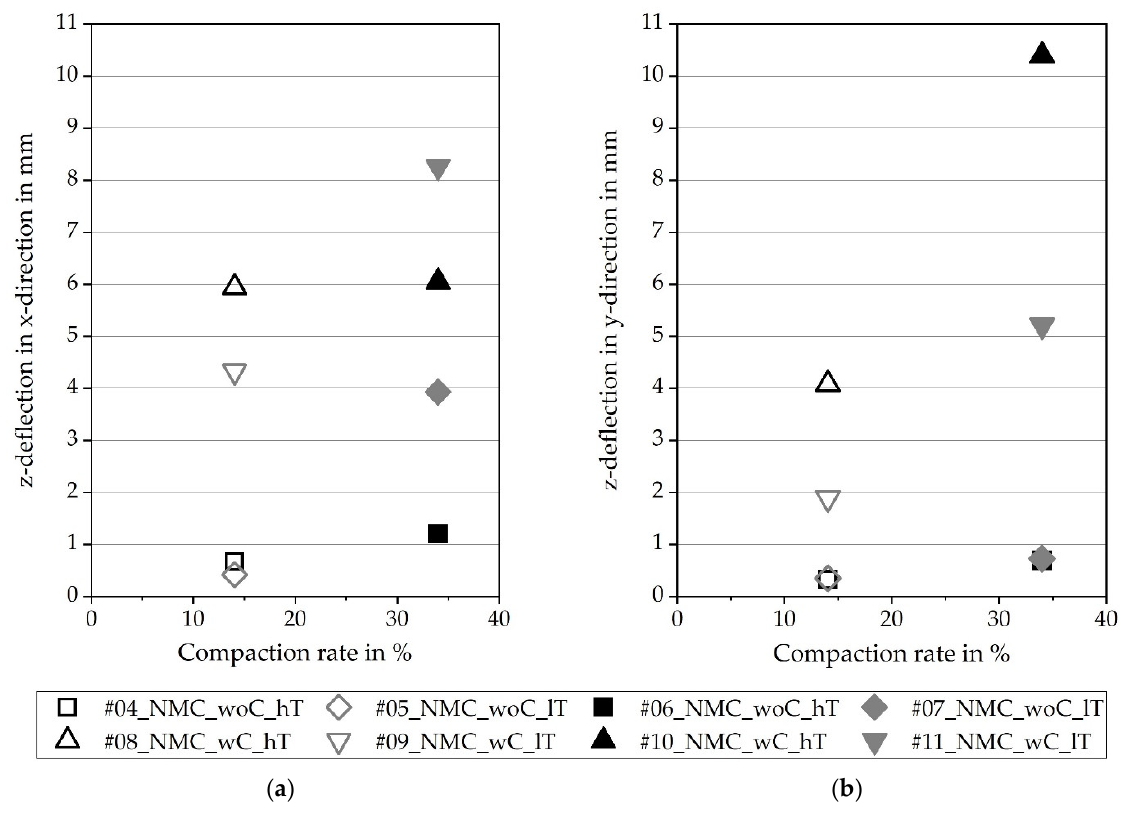
Figure 7. The z-deflection in: ( a ) x-direction; ( b ) y-direction. The uncoated collector influences the nearby coated area. As shown in Figure 8, on the right side, a clear blue line of negative elongations shows the stopping point of the lateral flow of the coating. In contrast, the x-elongation of the electrode without a collector (No. 7) sums at the right edge as a red line of high deformation. In both cases, a slightly striped pattern is visible in the y-direction, which also confirms the prevention of unhindered expansion in the